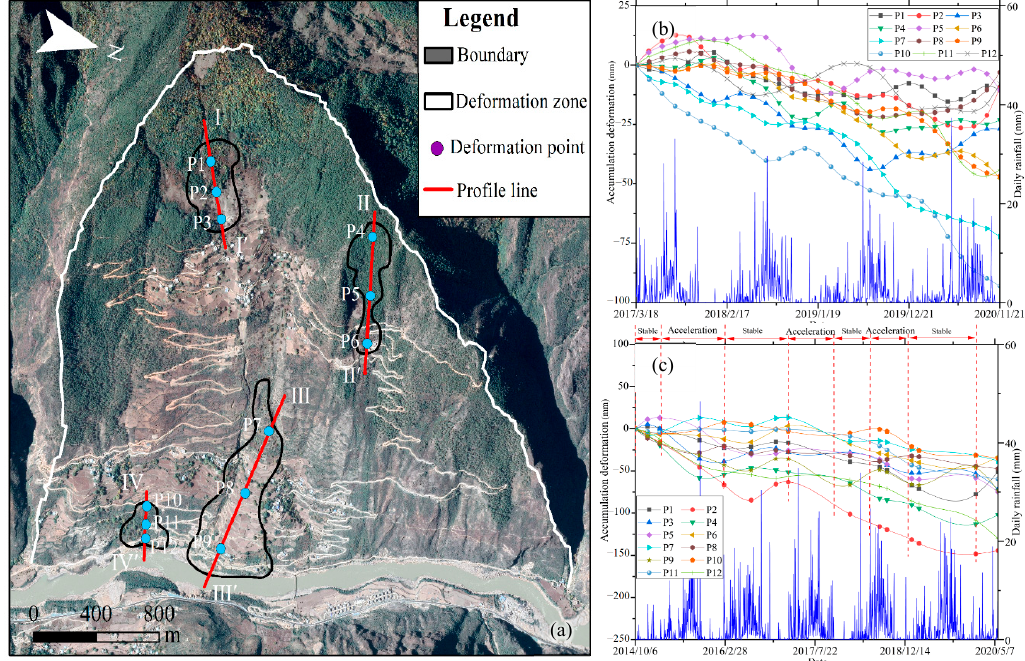
Figure 9. Time series deformation of KZG landslide, ( a ) the distribution map of the selected deformation points, ( b ) Sentinel-1A data, and ( c ) ALOS-2 data.